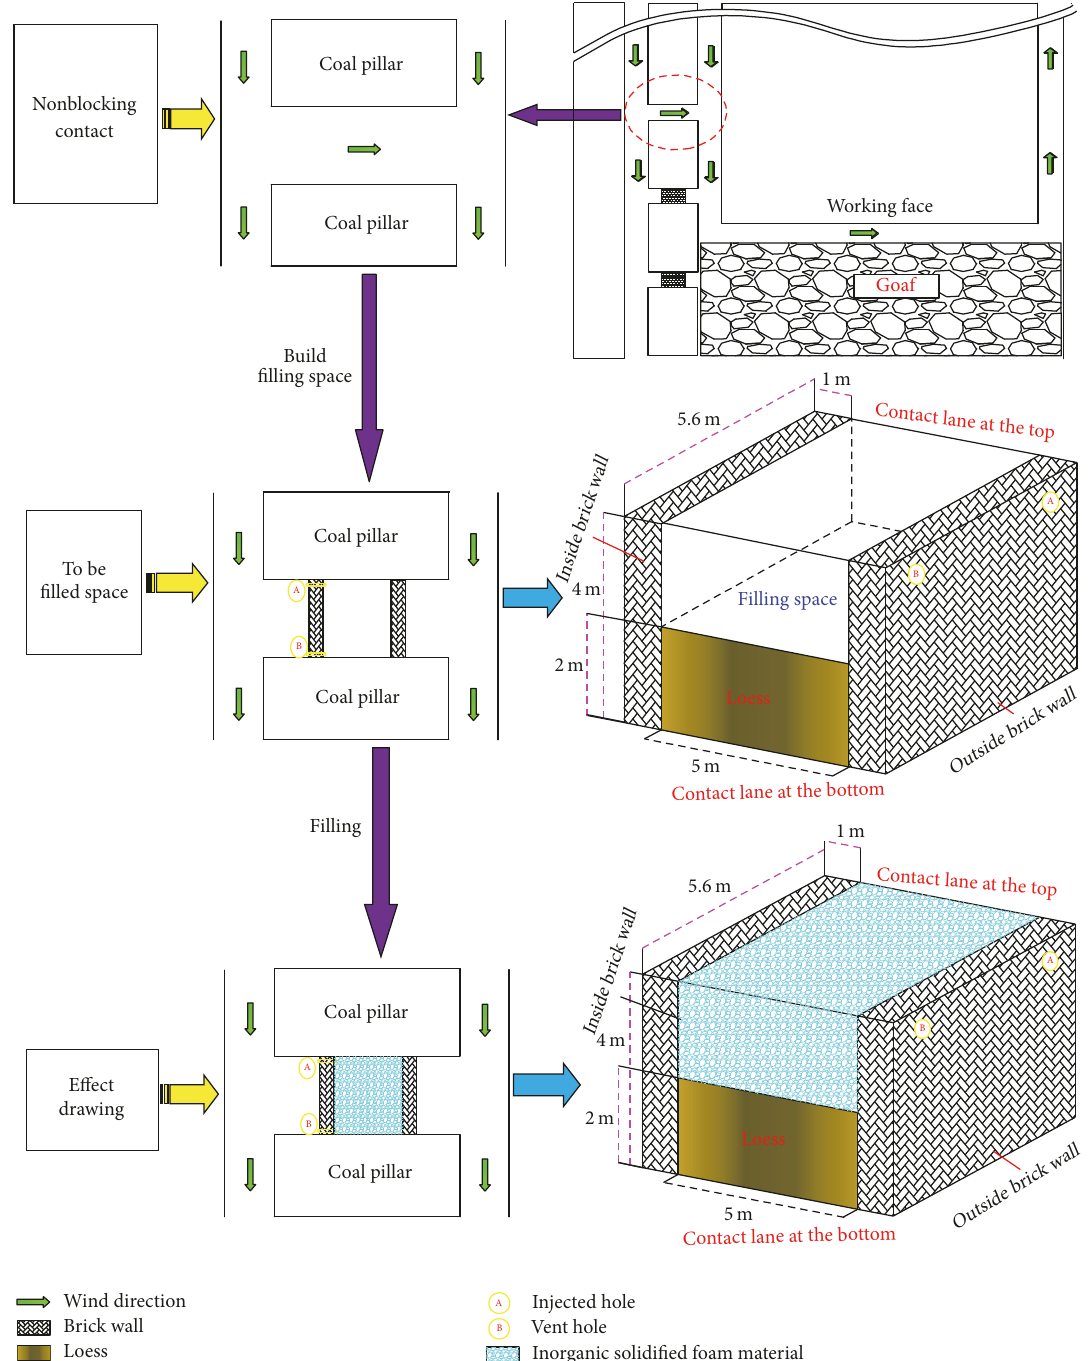
Figure 10: Sketch map of the grouting, filling, and sealing of the